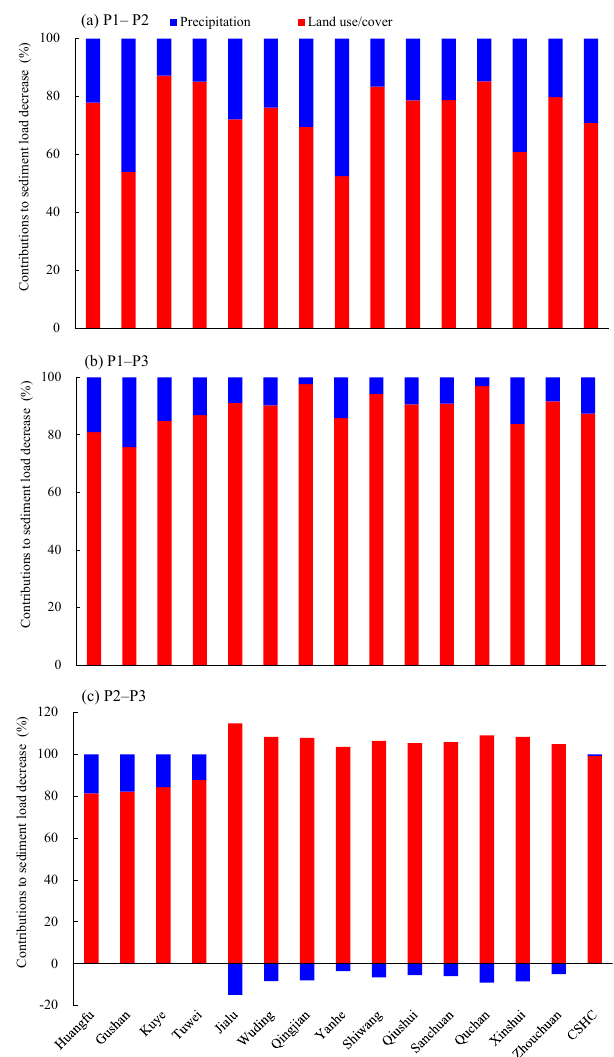
Figure 8. Contributions of precipitation and land use/cover to re- ductions of sediment load from (a) the reference period (P1) to period-2 (P2), (b) the reference period (P1) to period-3 (P3), and (c) period-2 (P2) to period-3